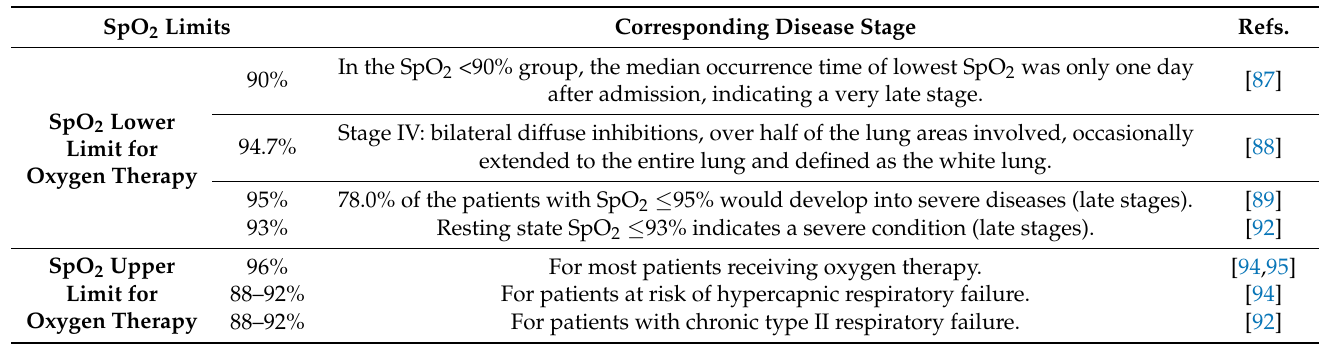
For patients with chronic type II respiratory